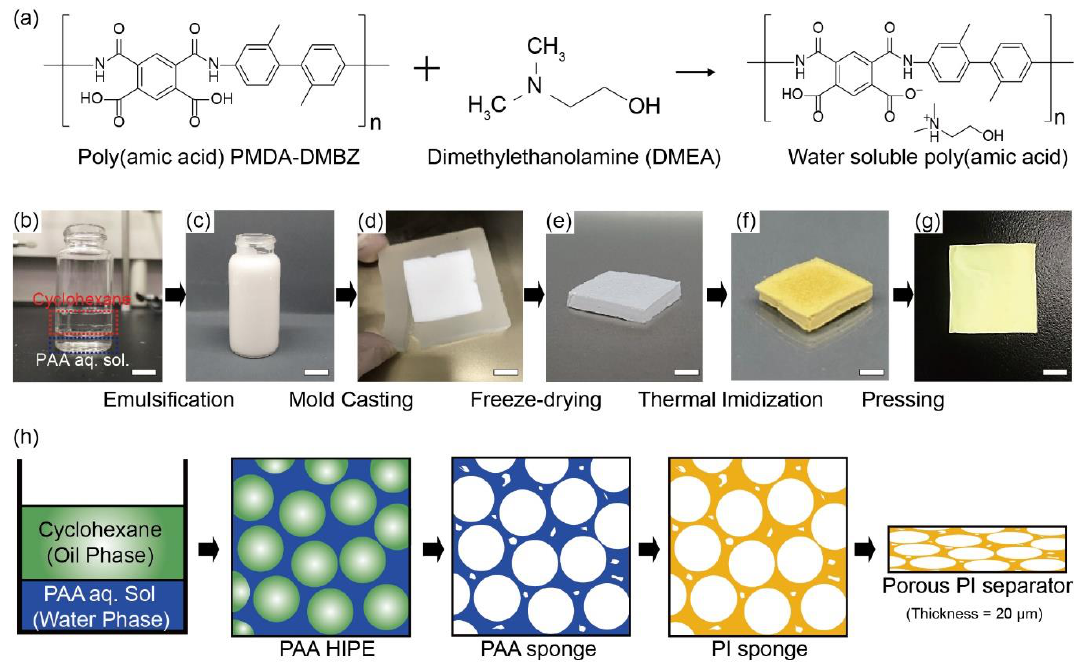
Figure 1. ( a ) Molecular structures of pyromellitic dianhydride - 2,2′ -dimethylbenzidine (PMDA- DMBZ)-based water-soluble poly(amic acid) (PAA) and dimethylethanolamine (DMEA), ( b – g ) the overall fabrication procedure of porous polyimide (PI) separator using oil-in-water (O/W) high internal-phase emulsion (HIPE) and subsequent pressing, ( h ) the schematic diagram of the internal structure of each step in the order of solution, PAA-HIPE, PAA-sponge, PI sponge, and the porous PI separator. All scales in ( b – g ) are 1 cm.